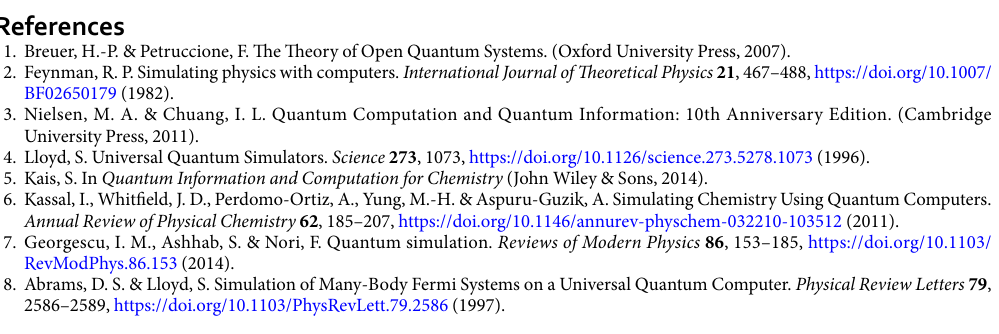
Figure 4. Showing the quantum circuit for U v list of the quantum circuits please see the